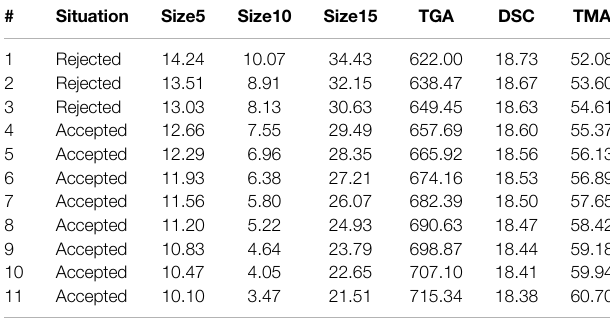
TABLE 1| Settingsofthecomputedplasticpellets followingthedirectionsignaled in Figure 6